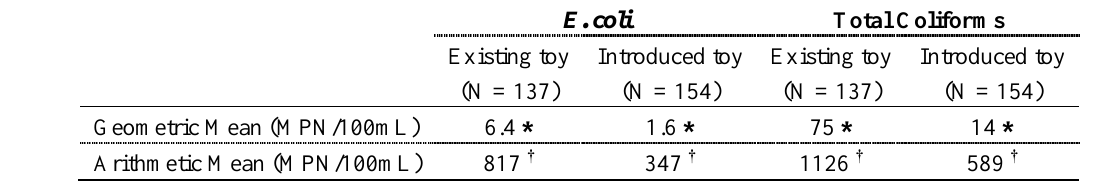
Table 2. Concentration of E. coli and total coliforms on both existing toys and toys introduced for two weeks then collected from participating households in January 2009 during an RCT of the plastic biosand filter in Copan,